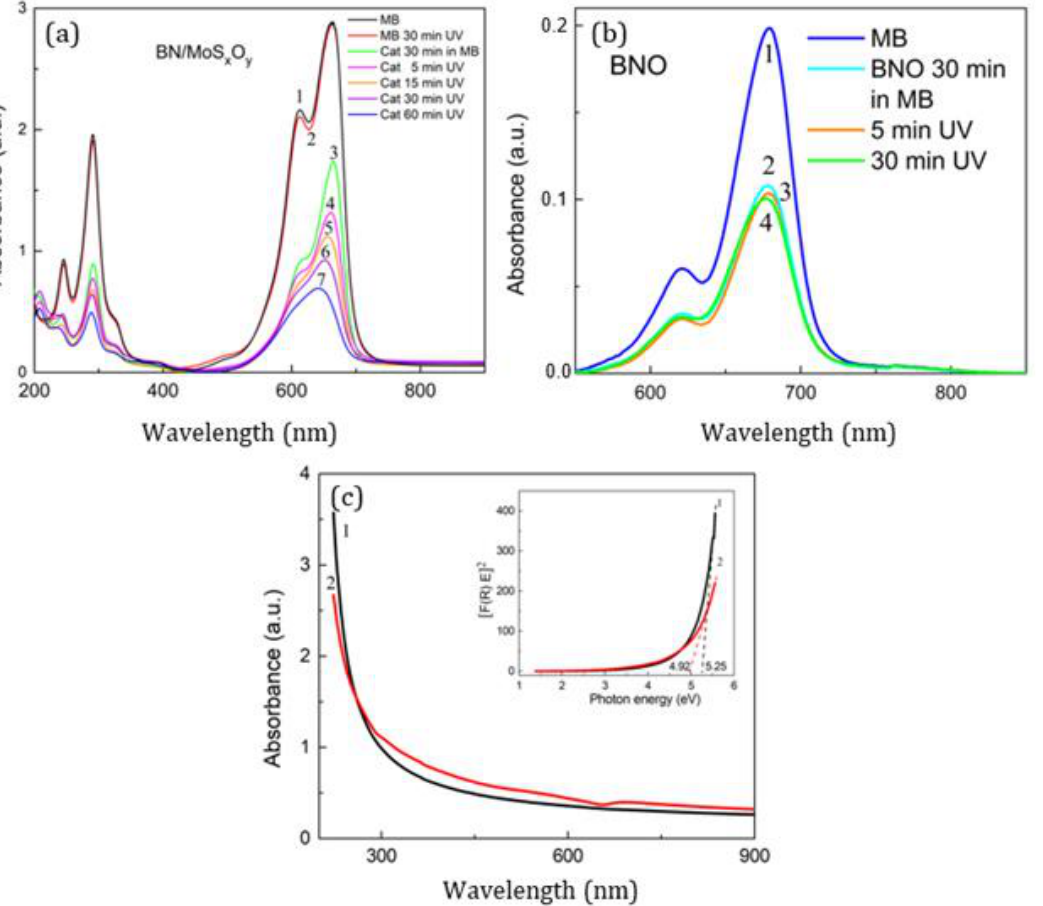
. Figure 5. UV-vis absorption spectra of MB water solution ( a ). 1—MB without UV-illumination, 2—MB after illumination for Figure 5. UV-vis absorption spectra of MB water solution ( a ). 1 — MB without UV-illumination, 30 min, 3—MB + a -MoS x O y / h -BN x O y (denoted as Cat) after 30 min exposure in the dark, 4–7—Cat after illumination for 5, 2 — MB after illumination for 30 min, 3 — MB + a -MoS x O y / h -BN x O y (denoted as Cat) after 30 min 15, 30, and 60 min. UV-vis absorption spectra of MB + h -BN x O y suspension ( b ). UV-vis absorption spectra ( c ) of h -BN x O y exposure in the dark, 4 – 7 — Cat after illumination for 5, 15, 30, and 60 min. UV-vis absorption (curve 1) and a -MoS x O y / h -BN x O y (curve 2) nanopowders suspended in methanol. The inset shows the Tauc plot and band gap values for h -BN x O y (curve 1) and a -MoS x O y / h -BN x O y (curve